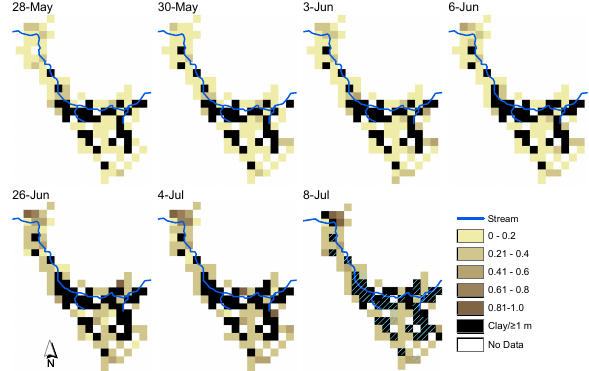
Fig. 8. Frost table depth at the wetland site. Area flooded in the spring on 28 May (hatched grids) overlays the frost table depths measured on 8 July. Any intersecting grids with flooding and ≥ 1m thaw indicate those flooded grids were at the same locations as the deepest thaw records. All values are in m and survey grids are mapped at a resolution of 15m by 15m.